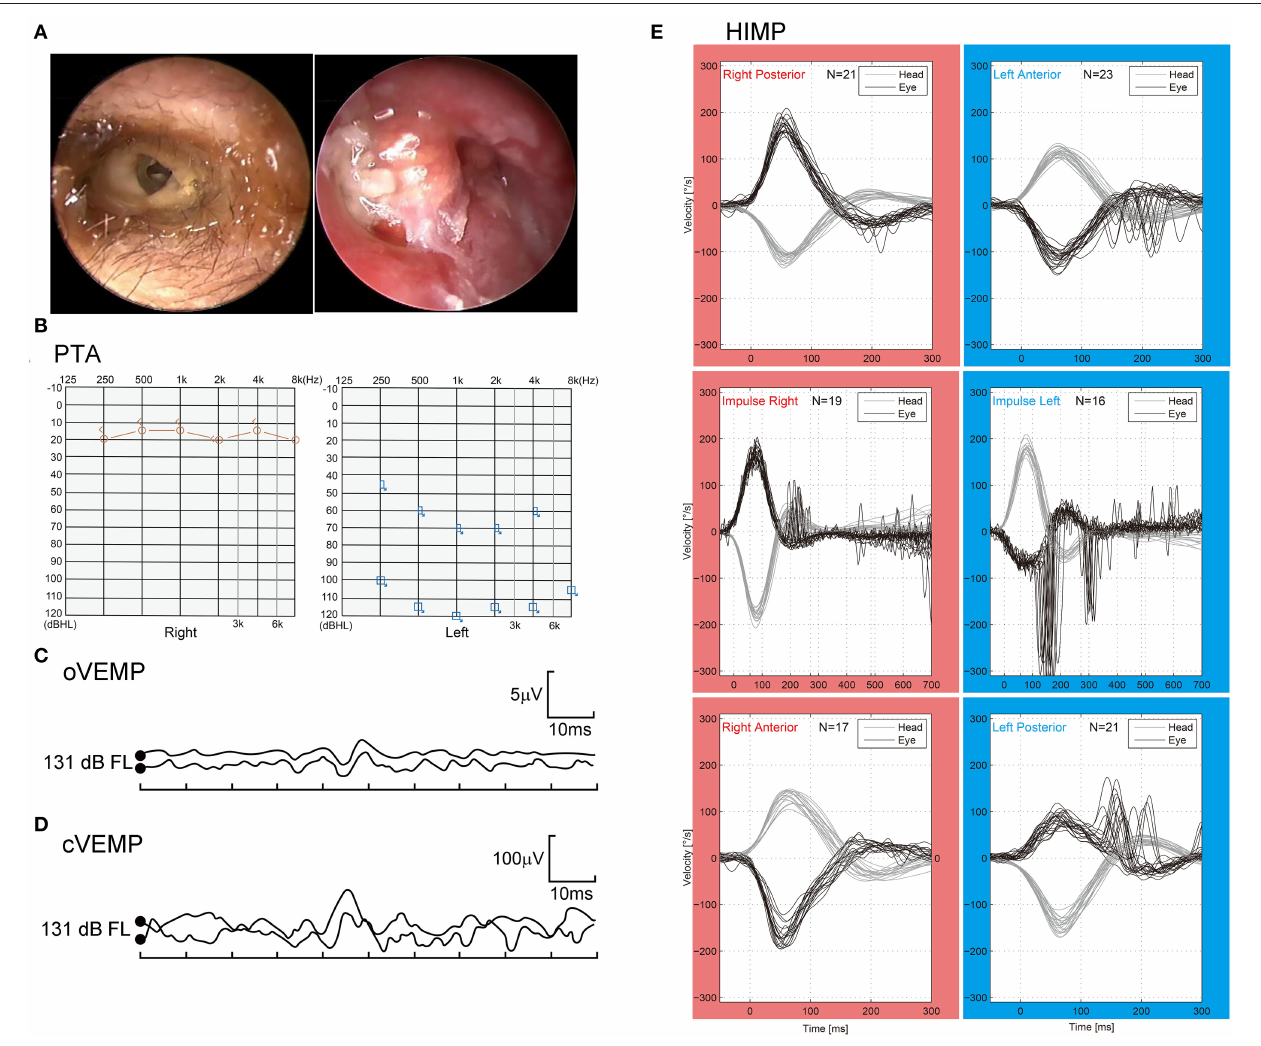
FIGURE 1 | (A) Oto-endoscope showed perforation in the left tympanic membrane with formation of granulation tissue and cholesteatoma. (B) There was no response to air and bone conductions in the left ear. PTA, pure tone audiometry. (C,D) The VEMPs could not be elicited in the left ear. VEMP, vestibular evoked myogenic potentials; oVEMP: ocular VEMP; cVEMP: cervical VEMP. (E) The HIMP revealed reduced VOR gains of the lateral, superior, and posterior semicircular canals in the left ear. HIMP, head-impulse paradigm; VOR, vestibulo-ocular